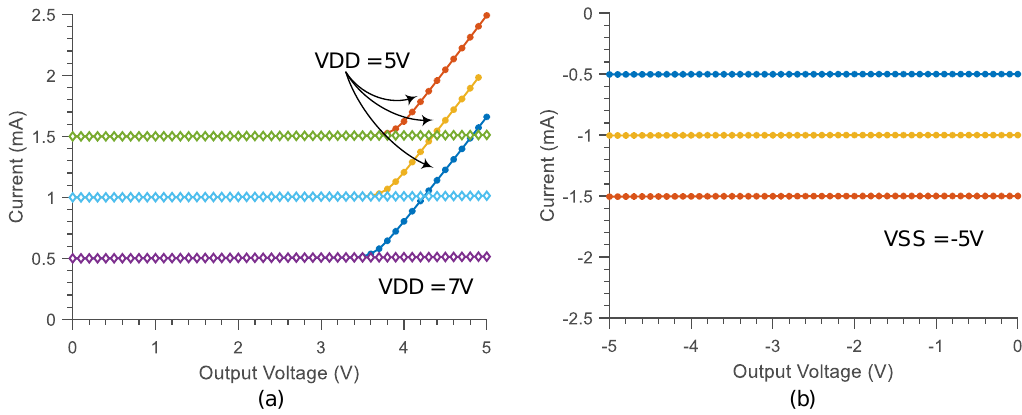
Figure 5. Measured voltage compliance for ( a ) anodic and ( b ) cathodic